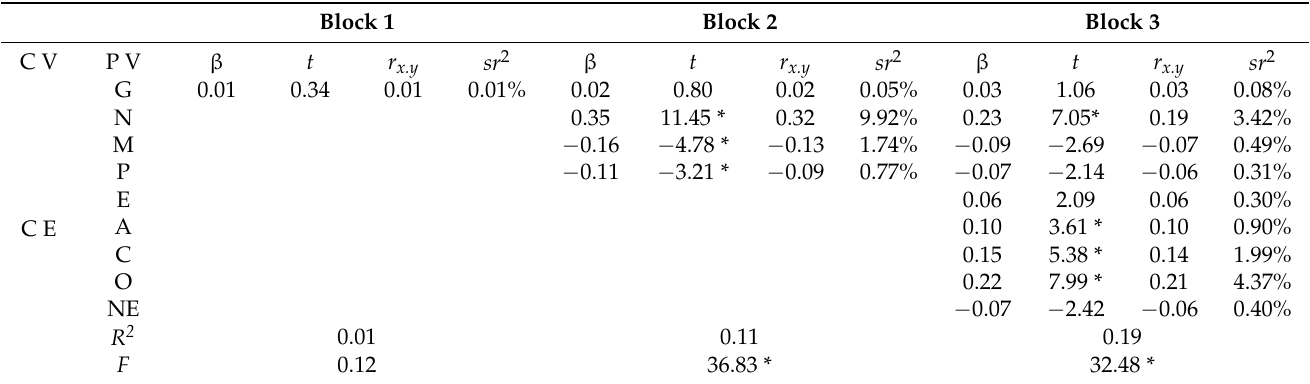
Table 3. Associations between civic engagement, Dark Triad traits, and the Big Five personality traits. Block 1 Block 2 Block